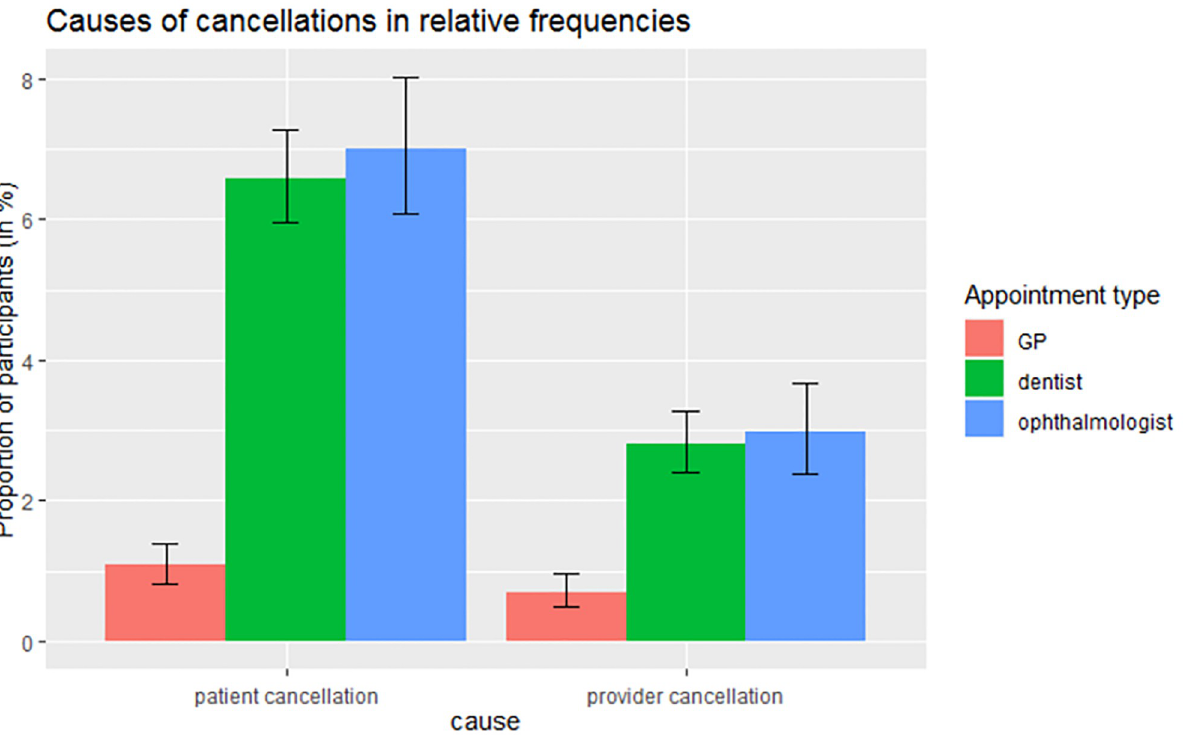
Fig 1. Comparison of relative frequency of cancelled appointments among GPs, dentists and ophthalmologists (each percentage is with respect to the number of participants who had made any appointment in the respective category), showing Clopper-Pearson confidence intervals for binomial